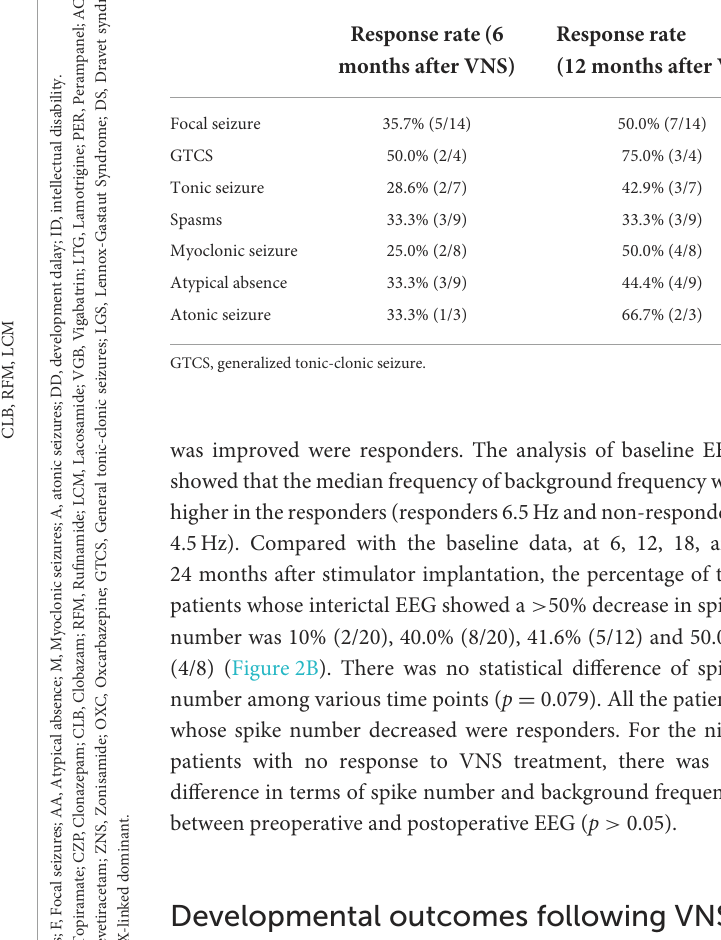
TABLE 2 The response rates of each seizure